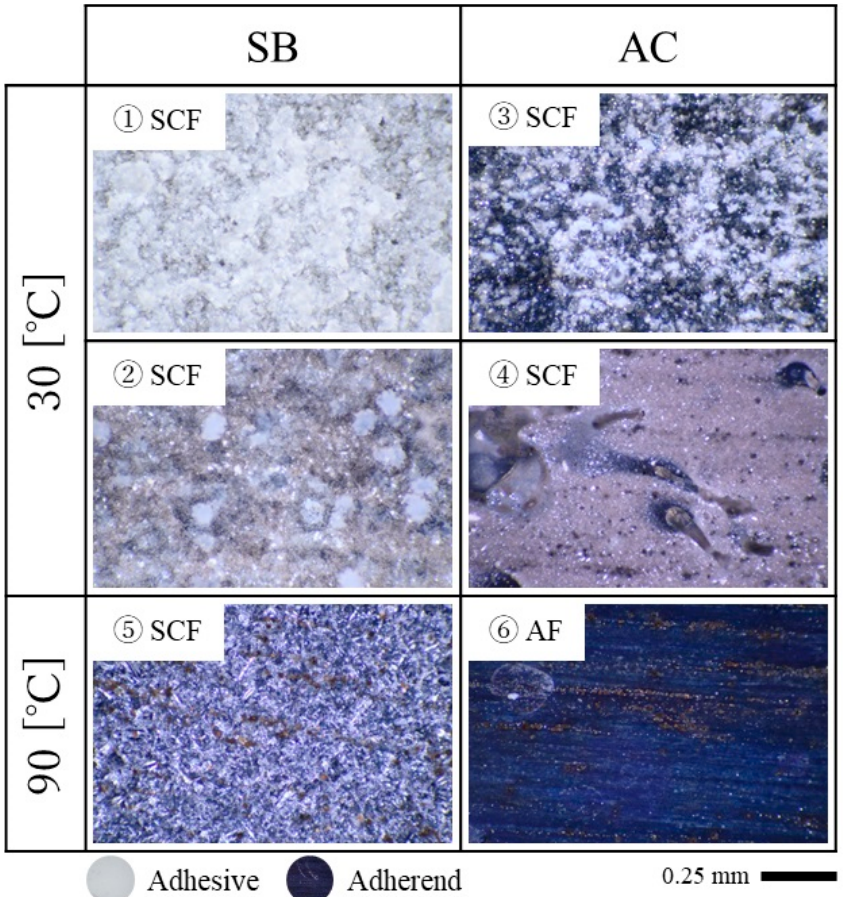
Figure 12. Magnified photograph under a microscope at selected points from Figure 11 (SCF: special cohesive failure: AF: adhesive failure). cohesive failure: AF: adhesive